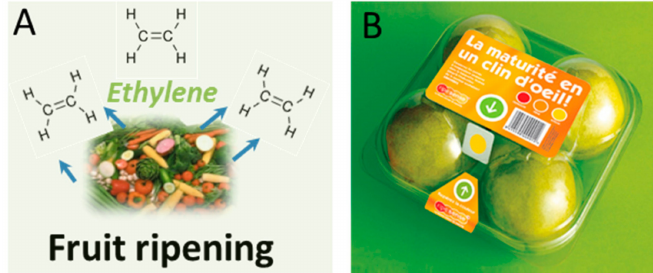
Figure 2. ( A ) Schematic illustrating the release of ethylene during fruit ripening; ( B ) example of a ripening label by RipeSense ® (RipeSense, Auckland, New Zealand) placed on the top of the package, where color changes from red to yellow according to the ripeness degree. Color development originates from the reaction of evolved gases with the label. Reproduced with permission from Reference